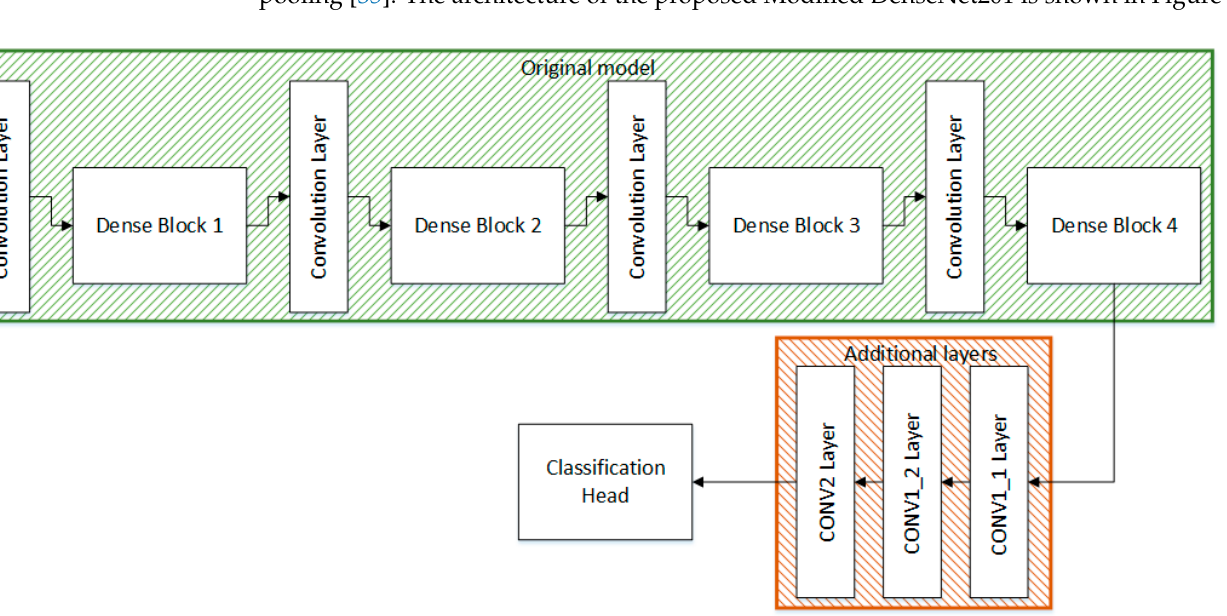
Table 2. Architecture of the proposed Modified DenseNet201.